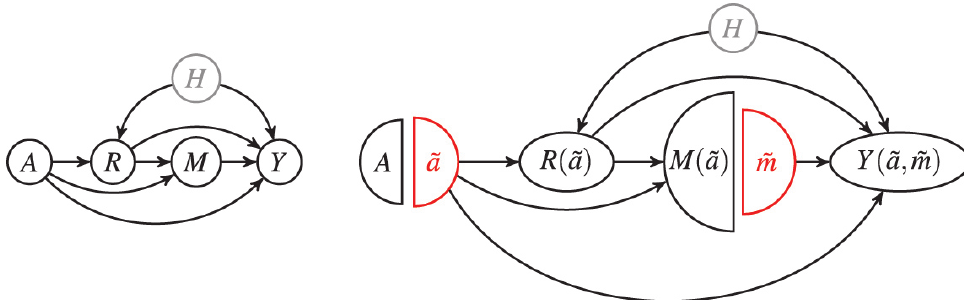
Figure 3: (A) A mediation uuu in which an unobserved variable u affects u , an exposure-induced confounder, and u . The black nodes represent observed random variables, and the arrows represent possible causal effects of one random variable on another. (B) The single-world intervention graph in the setting of (A) that has been intervened on to set u to ̃u ∈ {u,u ∗ } and u to ̃u . The black nodes represent random variables under this intervention, the red nodes represent the level an intervened random variable takes under this intervention, and the arrows represent possible causal effects of one variable under this intervention on another. In each panel, the gray node represents a hidden random